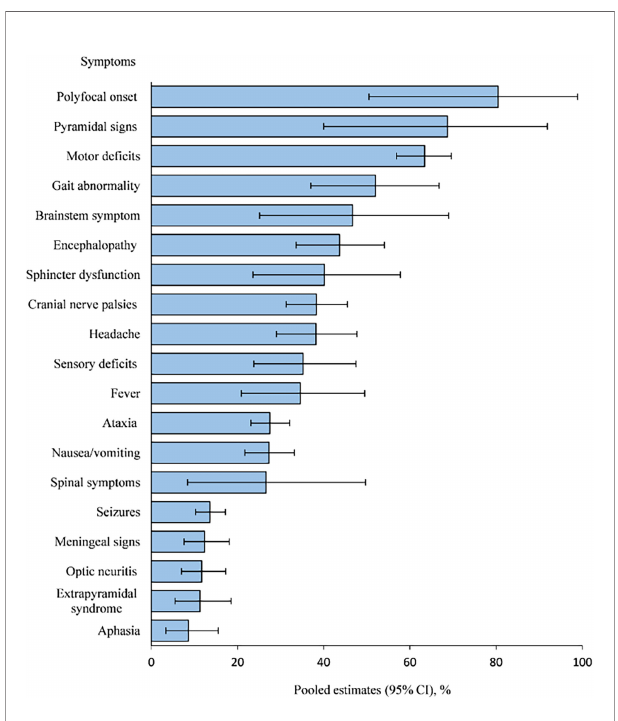
FIGURE 2 | Symptoms and signs of patients with